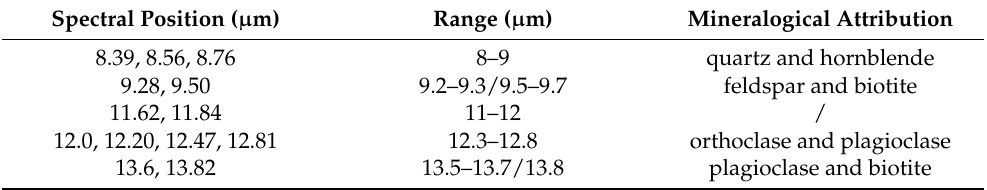
Figure 8. Distribution of the common spectral features of the monzonite samples. The colour of points represents the depth values of the extracted features. The arrows are used to point out the common and similar spectral features of the monzonite samples. Table 1. List of selected spectral features for the identification model of